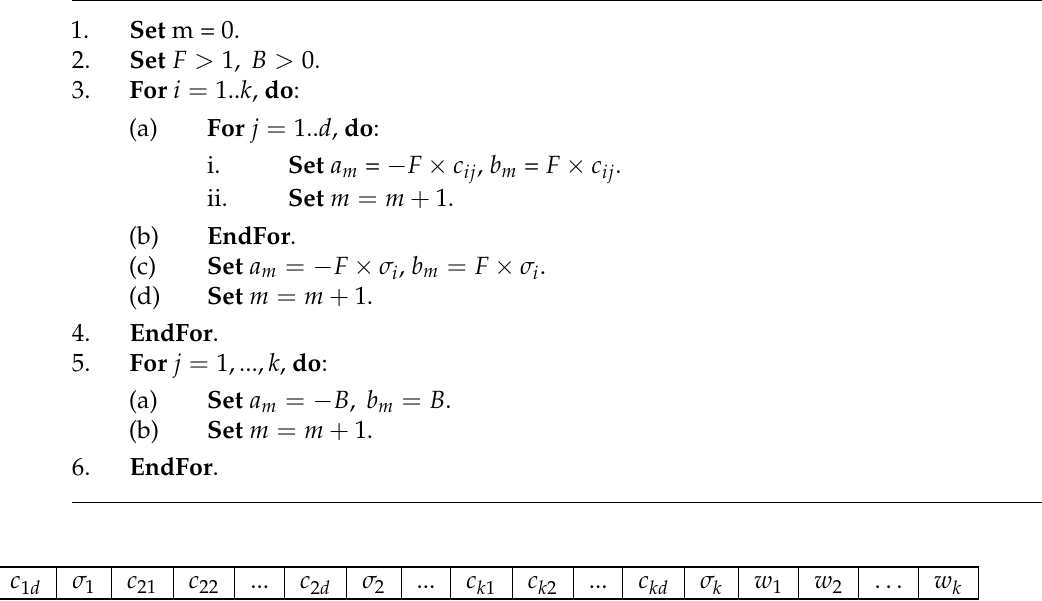
Figure 2. The scheme of the particles in the current PSO